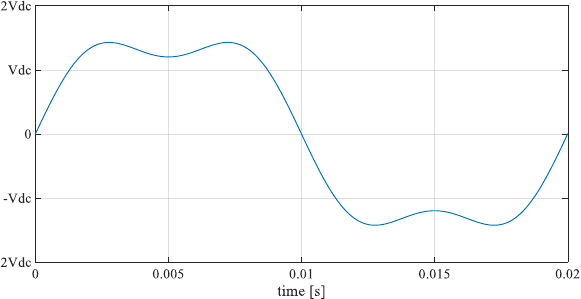
Figure 4. Third Harmonic Injection (THI) modulating signal.